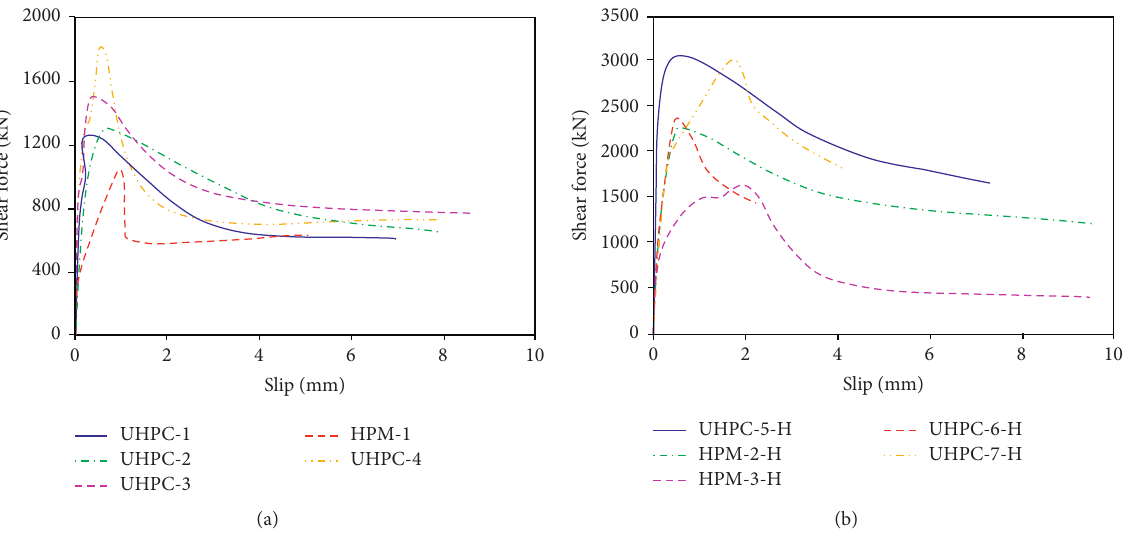
Figure 14: Shear-slip curves: (a) specimens without holes in steel rib; (b) specimens with holes in steel